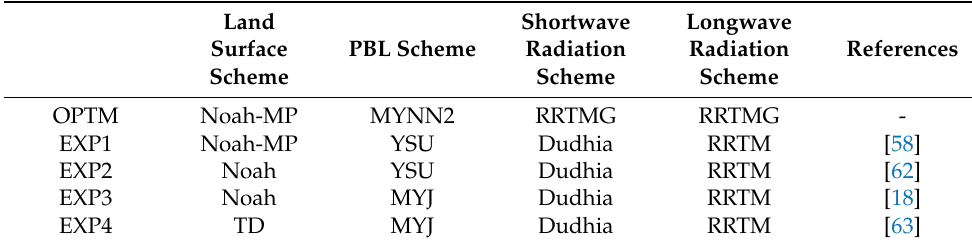
Table 4. List of the